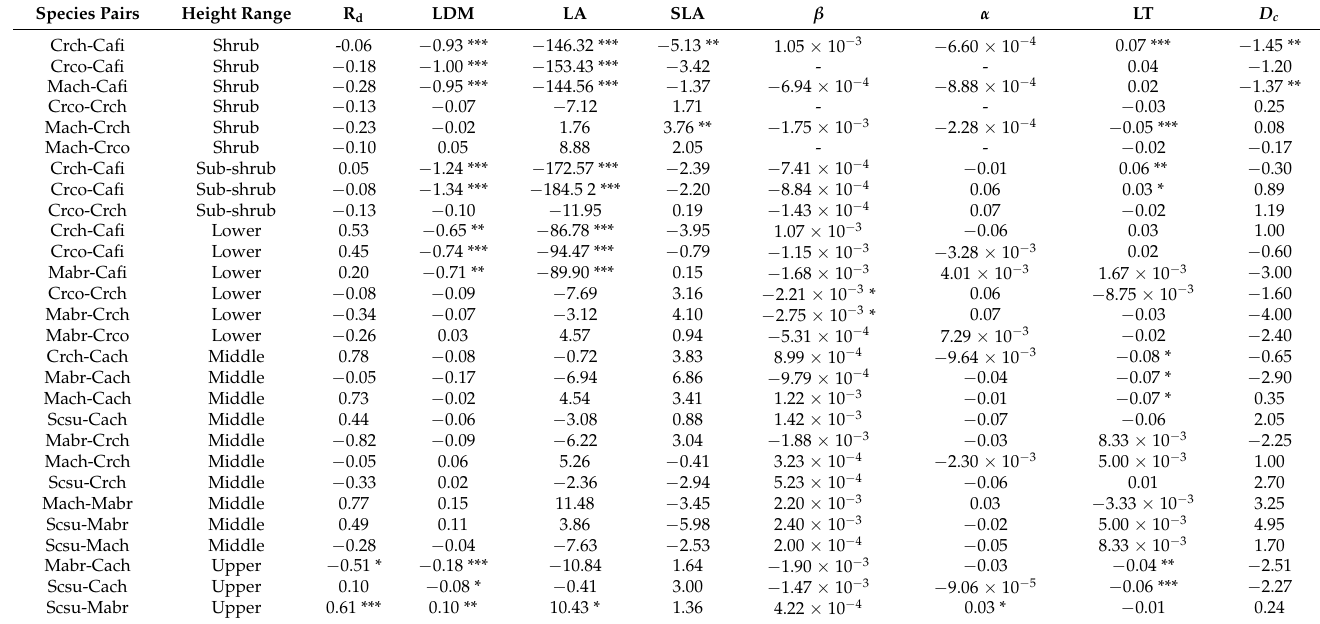
Table A4. Species differences in functional traits in the five different height ranges. Species differences in each functional trait were checked using a Tukey test at a 95% family-wise confidence level. Species pairs refer to the pairs of species used for comparison in each height range.